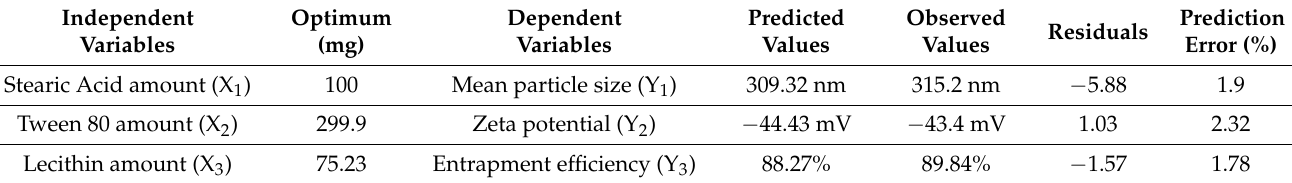
Table 4. Optimal calculated independent variables and observed, predicted, and residual values for dependent